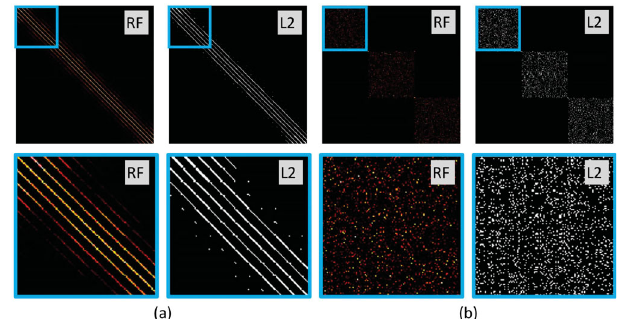
Fig. 3 Affinity matrices obtained by the proposed forest-based metric and the L 2 -norm followed by k NN on (a) corner and (b) 3 D clusters datasets.